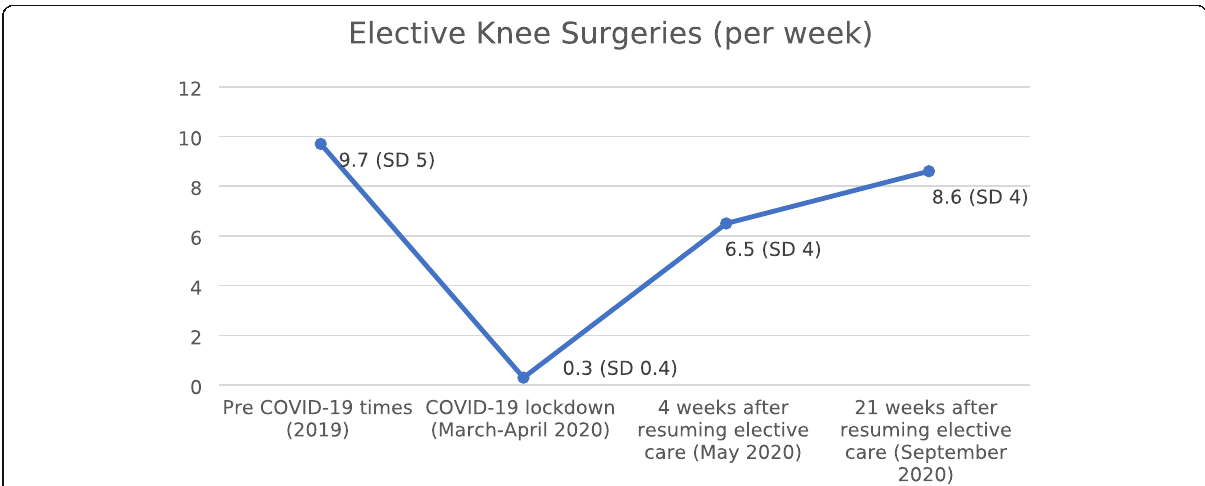
Fig. 1 Amount of elective knee surgeries per week during: pre-COVID-19 times (March- April 2019); COVID-19 lockdown (March – April